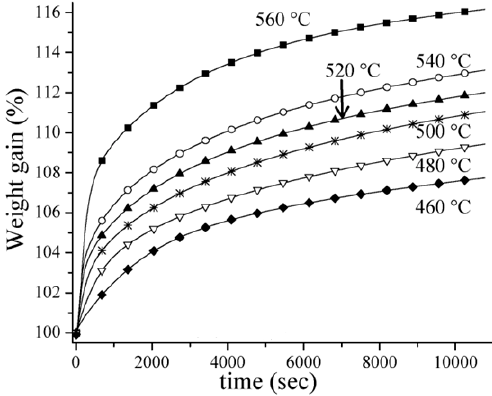
Figure 6. Isotherms obtained in a CO 2 atmosphere at various temperatures [28].